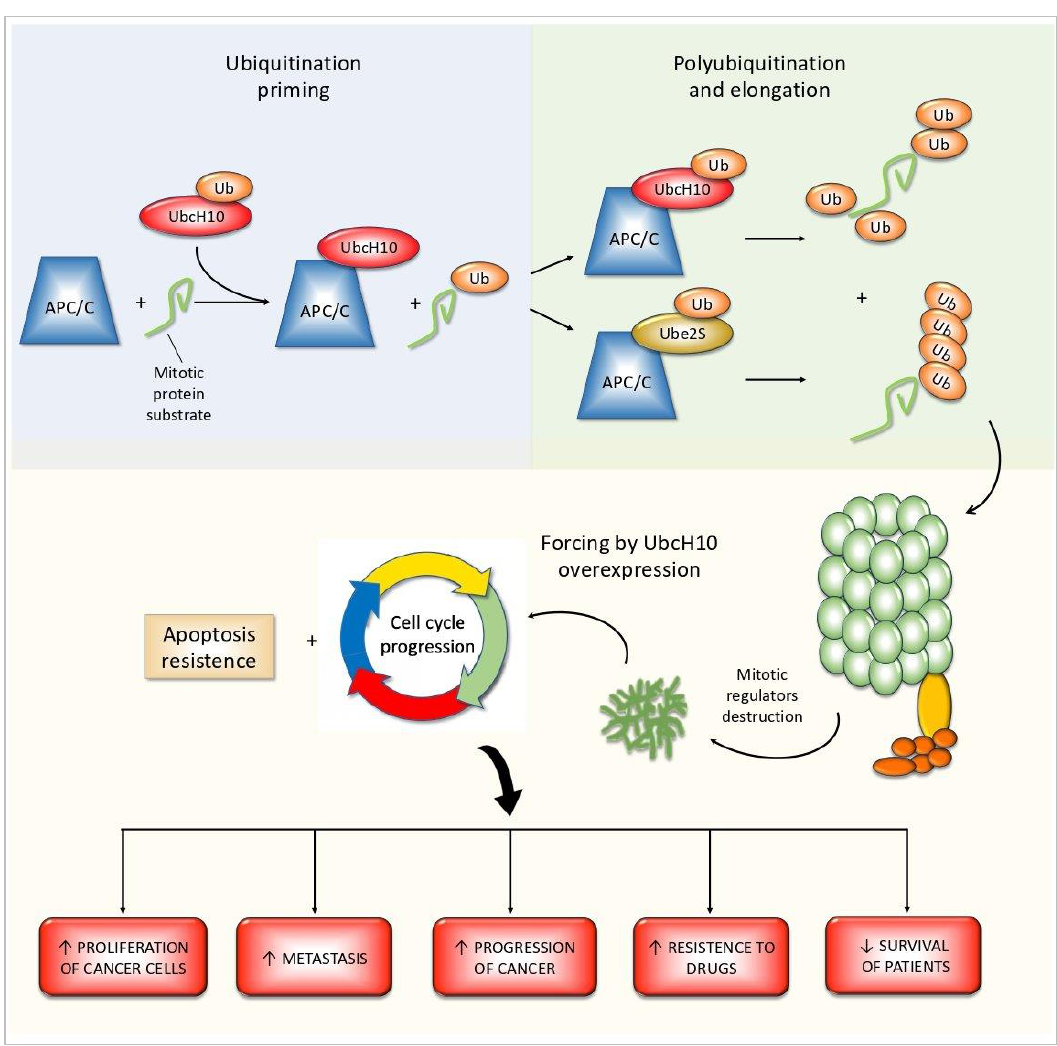
Figure 1. UbcH10 is together with Ube2S, the ubiquitin-conjugating enzymes (E2) partner of anaphase-promoting complex/cyclosome (APC/C) ubiquitin ligases (E3) complex. UbcH10 is devoted to ubiquitination priming and multi ubiquitination, while Ube2S presides to further ubiquitin chain elongation. UbcH10 overexpression has been detected in samples of diverse solid tumors or hematologic cancers as well as in experimental models. Experimental silencing of UBE2C mRNA levels allowed to find a link between its overexpression and worsening of malignant characteristics.